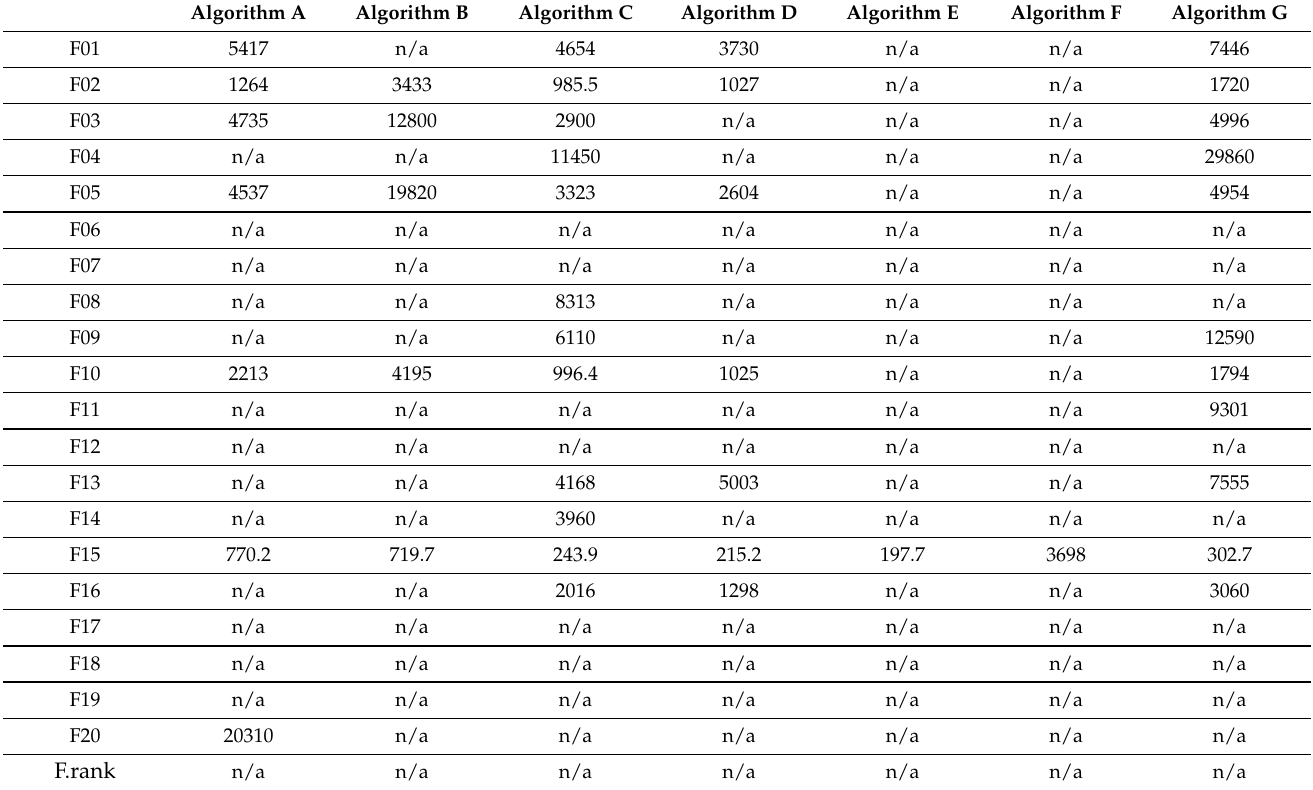
Table 6. Arithmetic mean of the required number of solutions—the correct